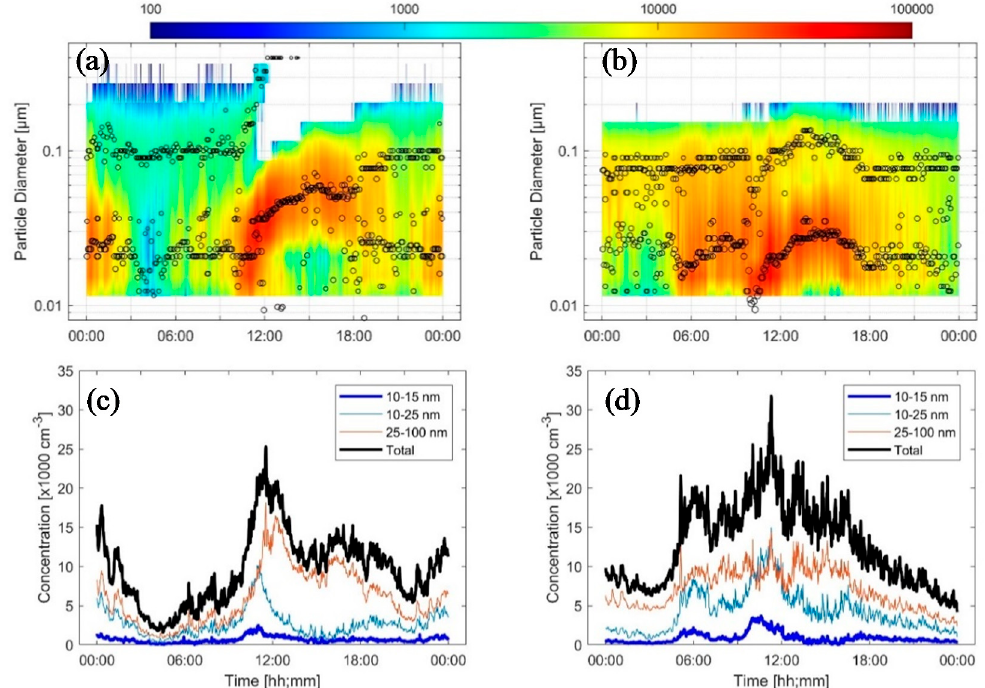
Figure 1. Examples of new particle formation (NPF) events: ( a ) Type I with continuous growth ( b ) Type II with growth and shrinkage. The events are illustrated by plotting the particle number size distribution spectrum ( a,b ) and number concentrations of three particle size fractions ( c , d ). The circles on the particle number size distribution spectrum indicate the geometric mean diameter of the modes and the size of the circle is proportional to the mode number concentration.